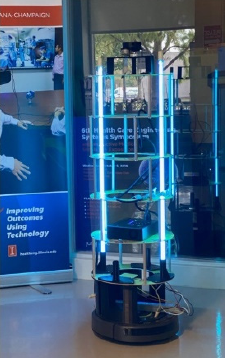
Figure 10. Functional prototype of the UVBot.